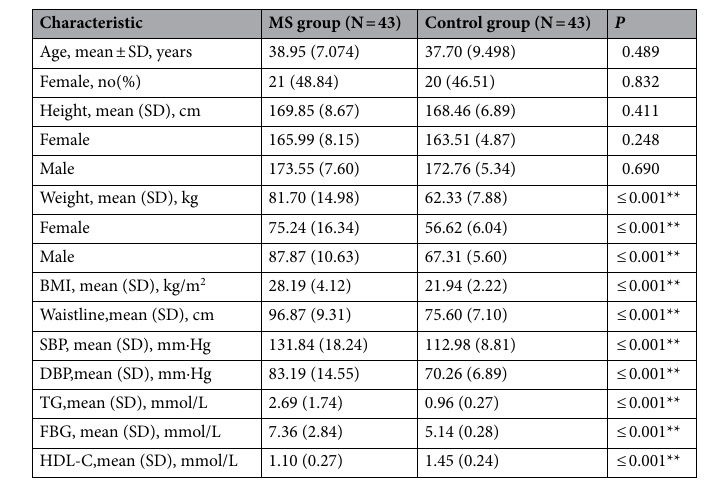
Table 3. Participant demographic and baseline characteristics. BMI Body Mass Index (calculated as weight in kilograms divided by height in meters squared), SBP systolic blood pressure, DBP diastolic blood pressure, TG triglyceride, FBG fasting blood glucose, HDL-C high density liptein cholesterol. **Significant